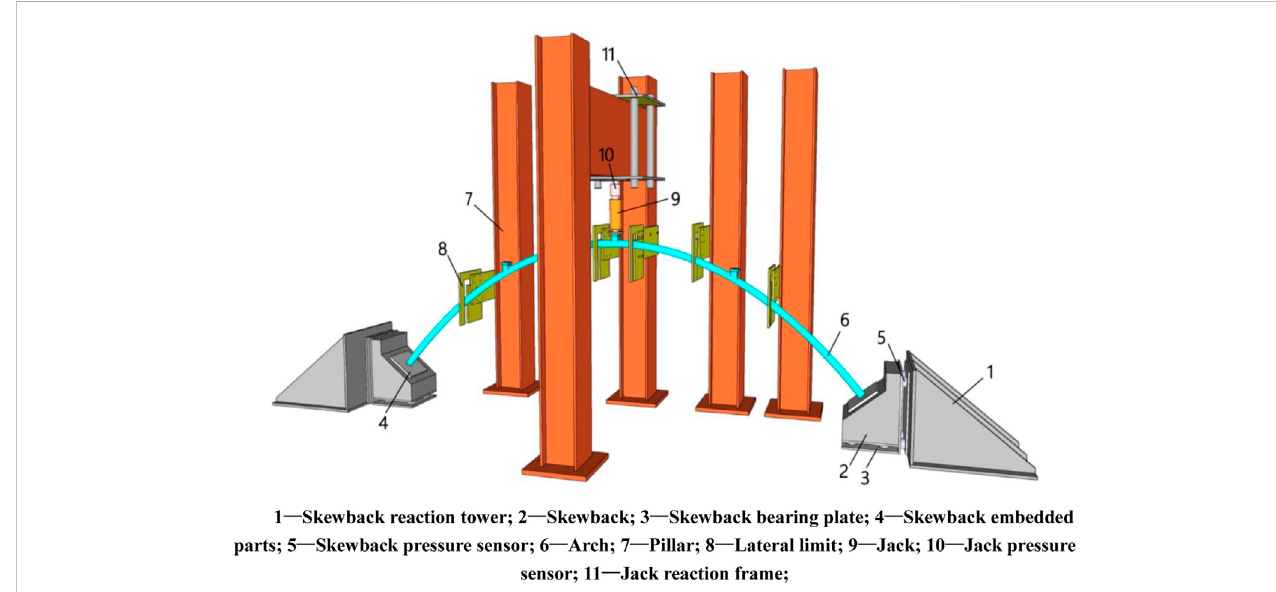
FIGURE 3 Overall diagram of the model.